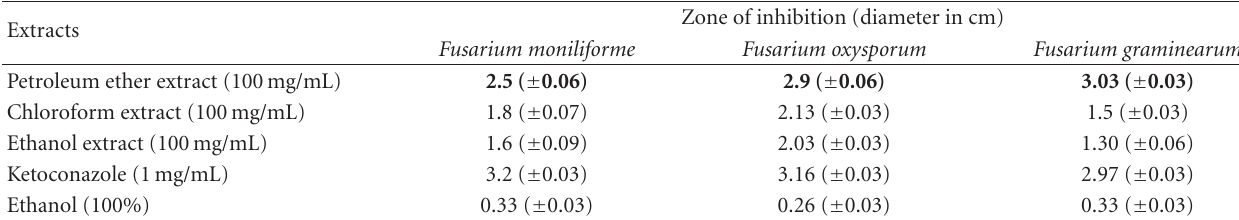
Table 1: Antifungal activity of seed extracts of Psoralea corylifolia L. against plant pathogens.